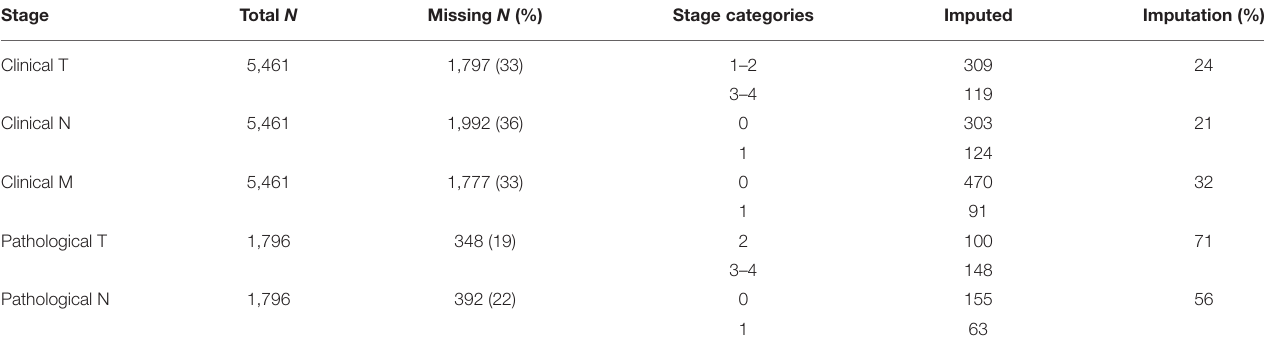
TABLE 3 | Missing data imputation